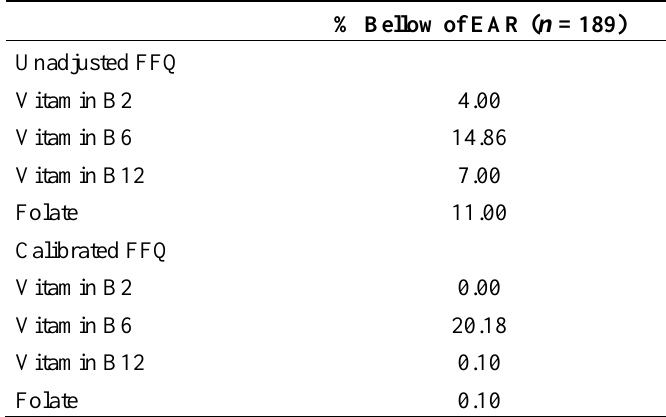
FFQ—Food Frequency Questionnaire; EAR—Estimated Average